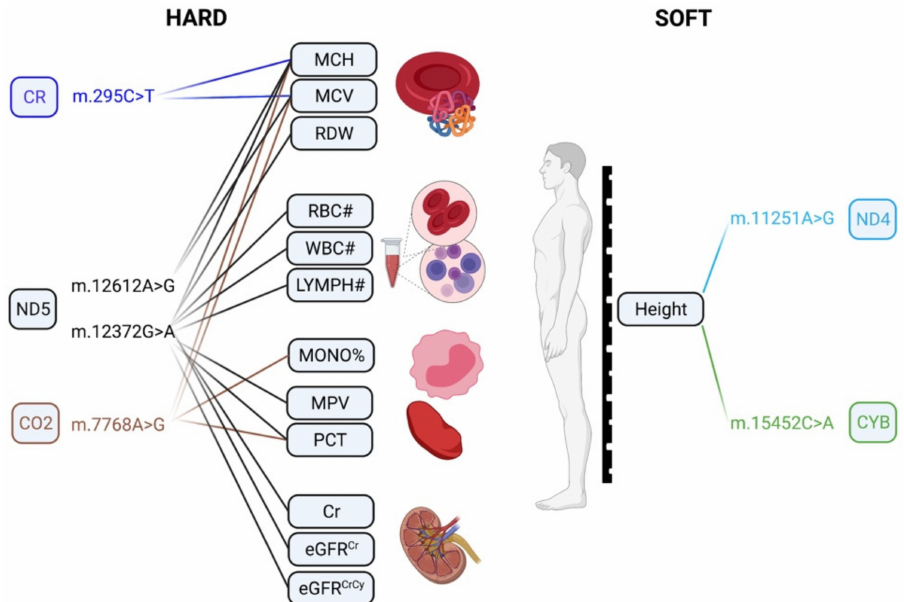
Figure 5. A visual overview of the previous findings for HARD and SOFT CAD MT-SNV associations in UK Biobank reported by ref. [58]. Created with BioRender.com, accessed on 22 February 2022. MCH: mean corpuscular hemoglobin; MCV: mean corpuscular volume; RDW: red blood cell distribu- tion width; RBC#: red blood cell count; WBC#: white blood cell count; LYMPH#: lymphocyte count; MONO%: monocyte percentage of white cells; MCV: mean corpuscular volume; PCT: plateletcrit; Cr: creatinine; eGFRCr: estimated glomerular filtration rate creatinine; eGFRCrCy: estimated glomerular filtration rate creatinine and cystatin